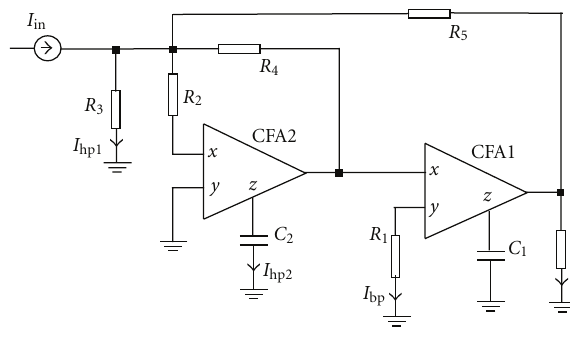
Figure 2: The proposed current-mode filter.